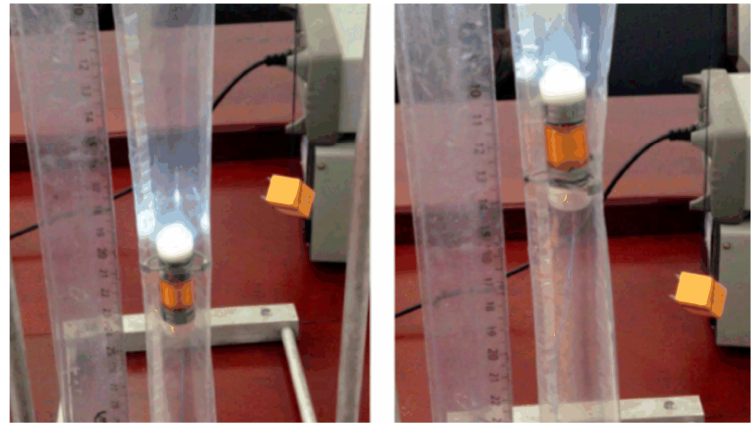
Figure 13. Performance test of the prototype in a flexible pipeline.